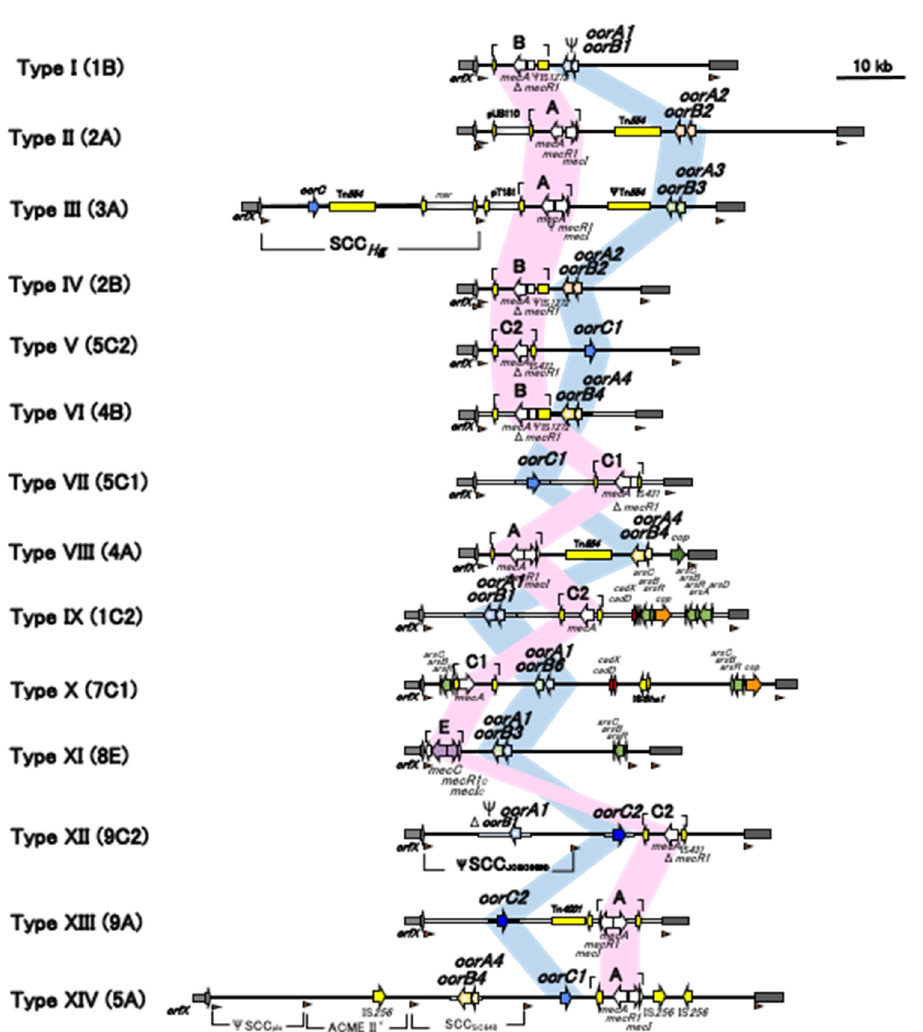
Figure 5. Schematic comparison of the current SCC mec types (14 December 2021). Adapted with permissions from Ref. [17]. 2009, American Society for Microbiology, and Ref. [28]. 2018, Dr. Marc Stegger, and Ref. [29]. 2020, Dr. Noriko Urushibara.